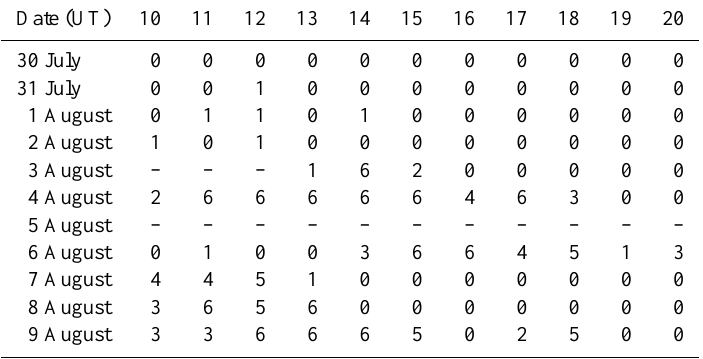
Table 2. Summary of occurrence rate of E -region field-aligned irregularities (FAI). Each number indicates the count of bin (10min) during which FAI occurred. – indicates a lack of data. Local time is